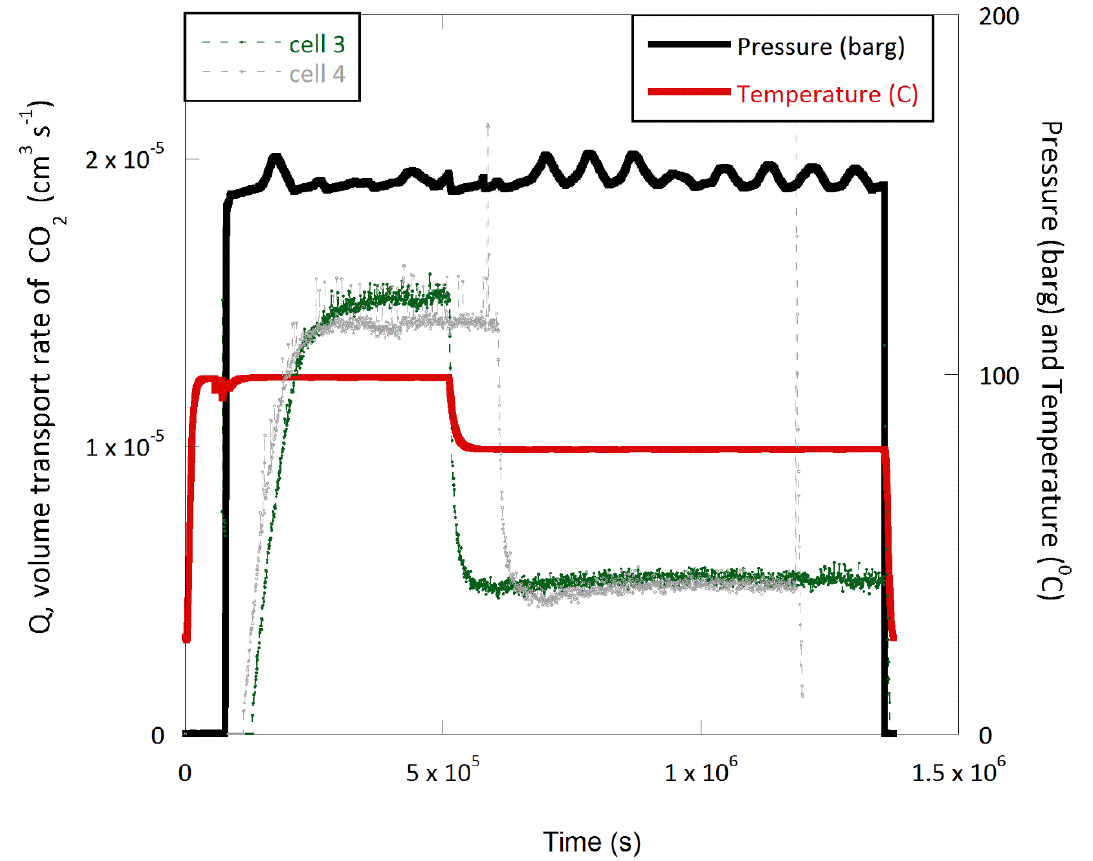
Figure 4. Conditioning of polyphenylene sulfide (PPS) at 100 °C followed by 80 °C; supercritical CO 2 with 1.5% H 2 S supplied throughout in two separate experiments.